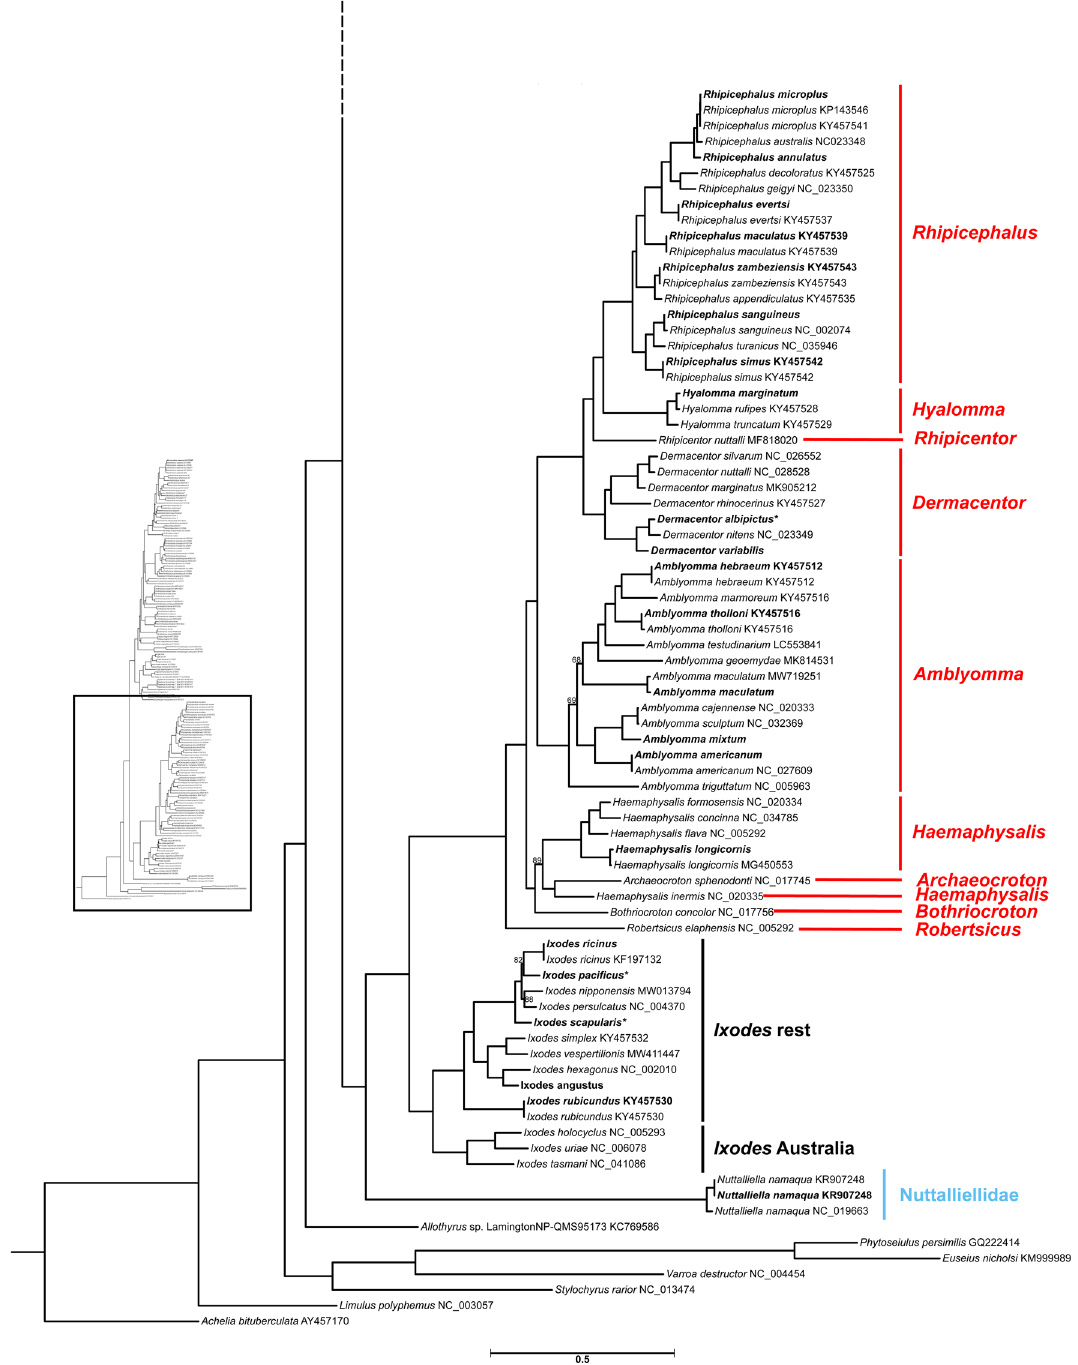
Figure 5. Ixodidae and Nuttalliellidae phylogeny. The Ixodidae and Nuttalliellidae portion of the maximum likelihood inferred phylogeny using the 10AA scheme from Kelava et al . 12 for the Argasidae, Nuttalliellidae, and Ixodidae is shown here including the root taxa. Ultra-fast bootstrap support is reported on the branches as the percentage of 100,000 replicates, those with < 90% support are shown. Tip labels that contain an asterisk (*) indicate that there were two samples of the same species, from the same locality, whose sequence alignment was 100% the same. GenBank accession numbers are located at the end of tip labels. Tip labels that are bolded indicate samples that were sequenced in this study and those that are bolded with GenBank accession numbers were a part of the benchmarking cohort. The Metastriates genera are indicated in red, the Prostriates genus subgroups are indicated in black, and the Nuttalliellidae family is indicated in blue. The scale bar indicates number of substitutions per site. The phylogeny to the left indicates the portion of the complete tick mitogenome phylogeny being viewed. The dotted branch indicates where this portion of the phylogeny meets the rest of the